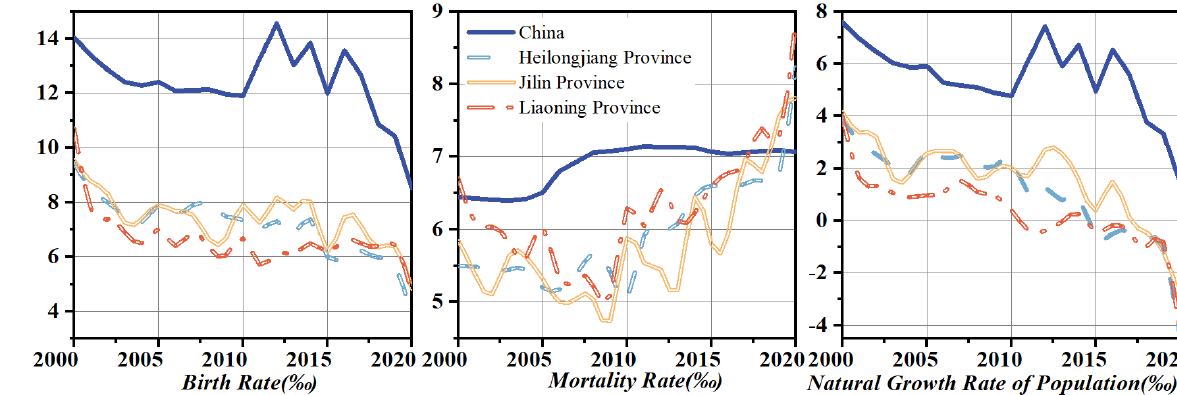
Figure 9. Variation in population birth rate, death rate, and natural growth rate in northeast China, 2000–2020.